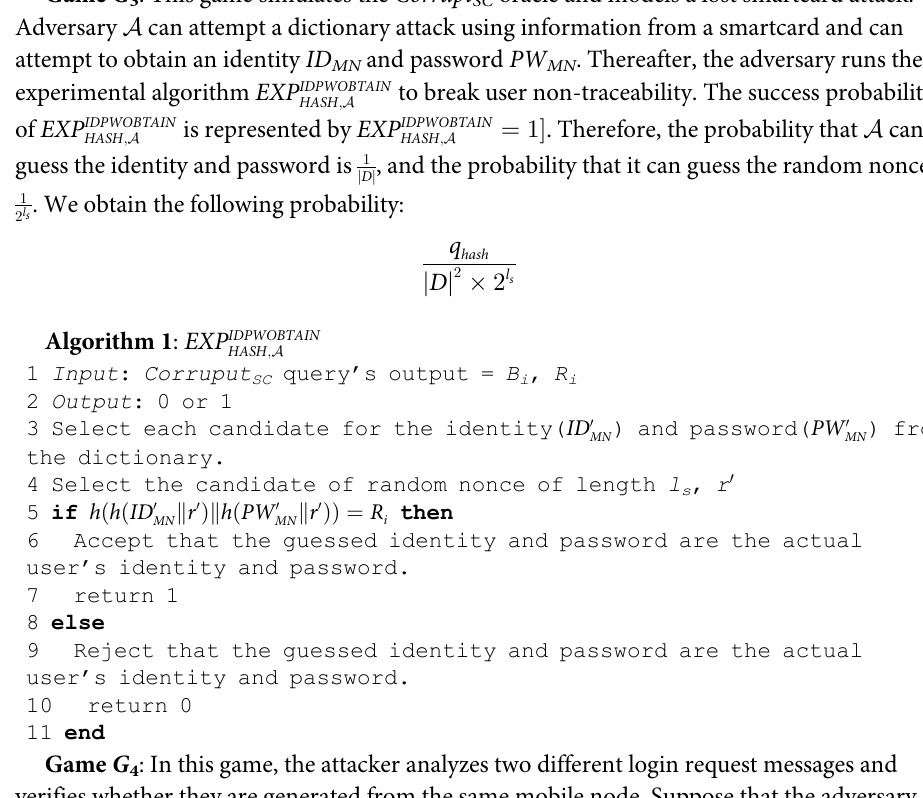
Algorithm 2 : EXP USERTRACE